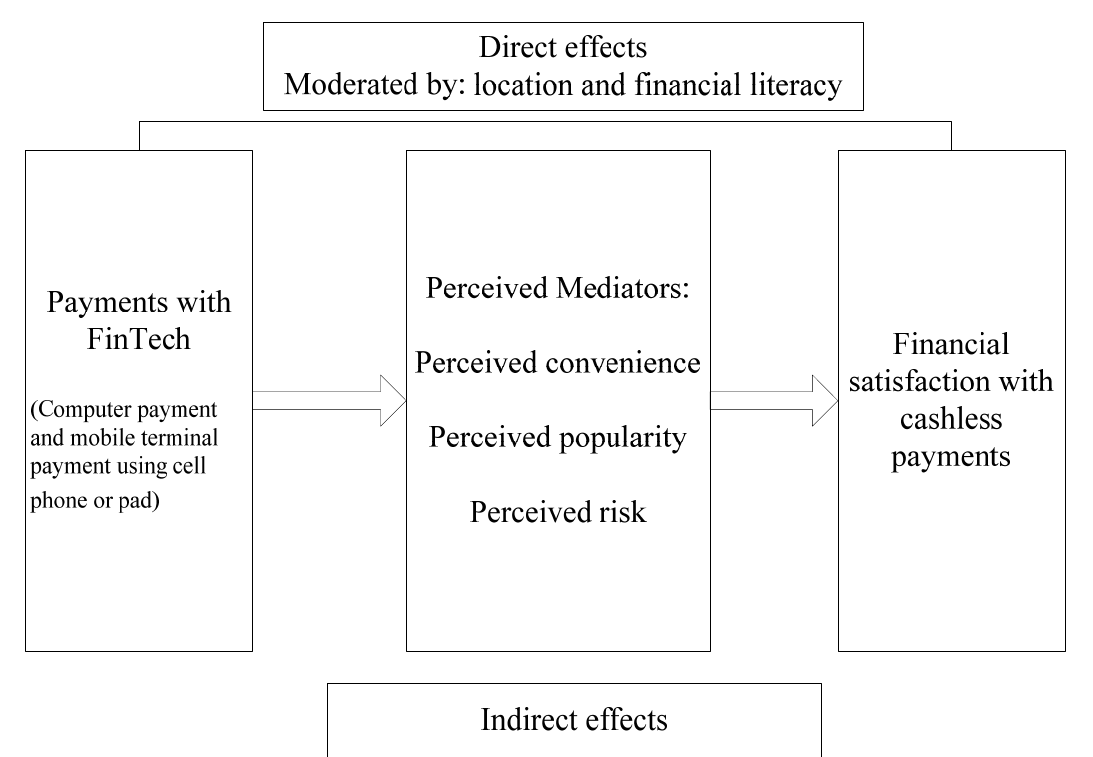
Figure 2. Conceptual framework between FinTech payments and financial satisfaction with cashless payments.